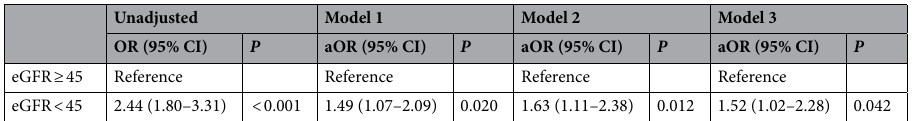
Table 3. The association between the stage of chronic kidney disease and sarcopenia. Model 1: adjusted for sex, age, body mass index, and pulse pressure. Model 2: adjusted for diabetes mellitus and hypertension in addition to Model 1. Model 3: adjusted for serum albumin and hemoglobin in addition to Model 2. CI, confidence interval; GFR, glomerular filtration rate; OR, odds ratio.